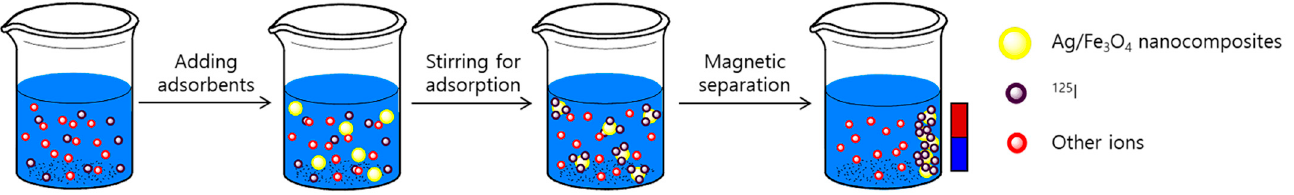
Figure 1. Schematic illustration of the desalination process using Ag/Fe 3 O 4 composite nanoadsorbents.